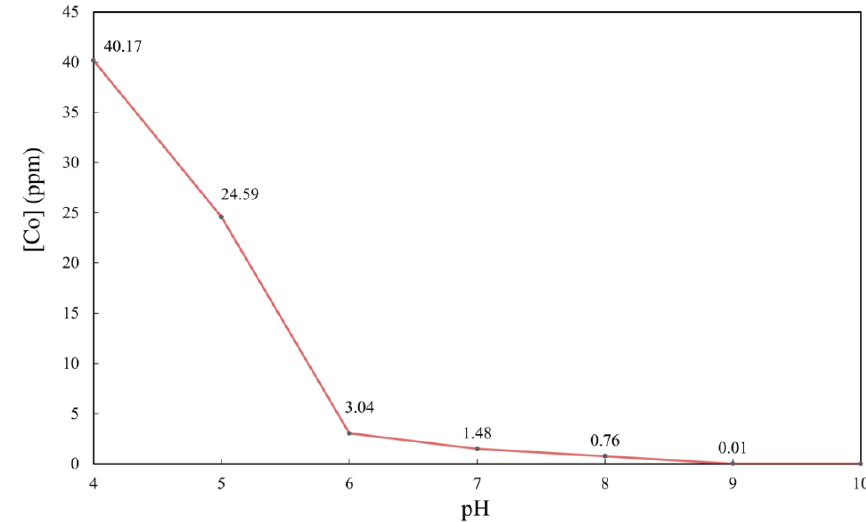
Figure 6. Effect of solution pH on Co leaching from a Cab-O-Sil-based SiO 2 /Co(OH) 2 nanocomposite into the aqueous solution, as revealed by ICP-OES analysis of the leachates.